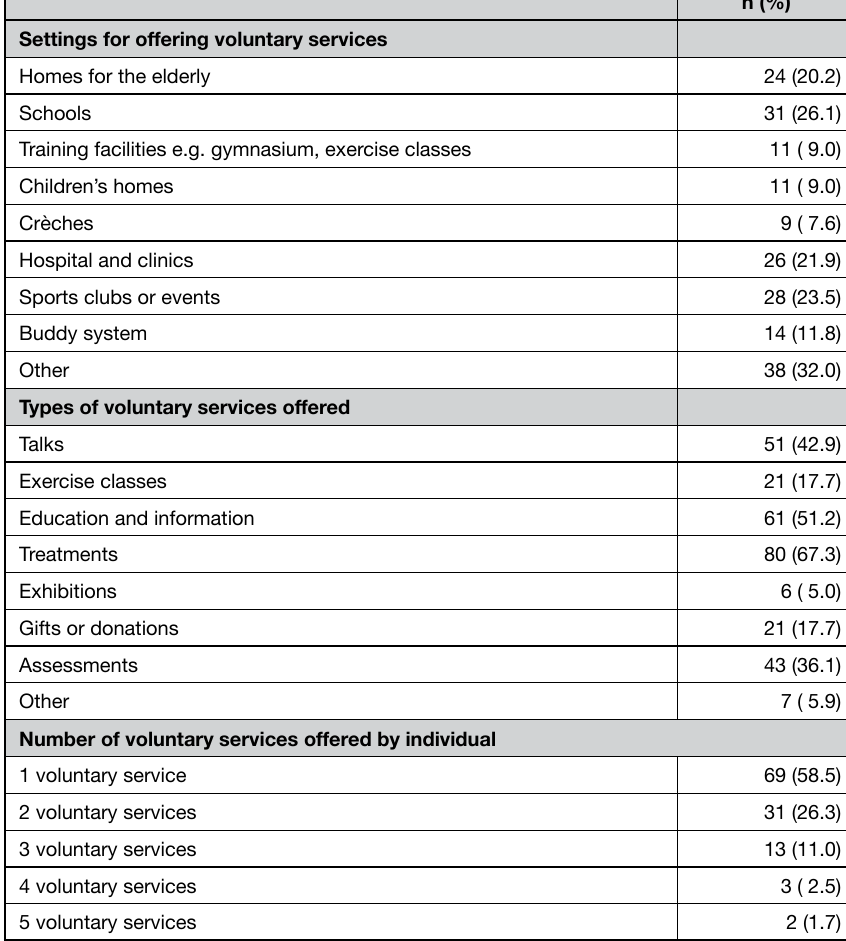
Table 6: Settings and Types of Voluntary Services Offered